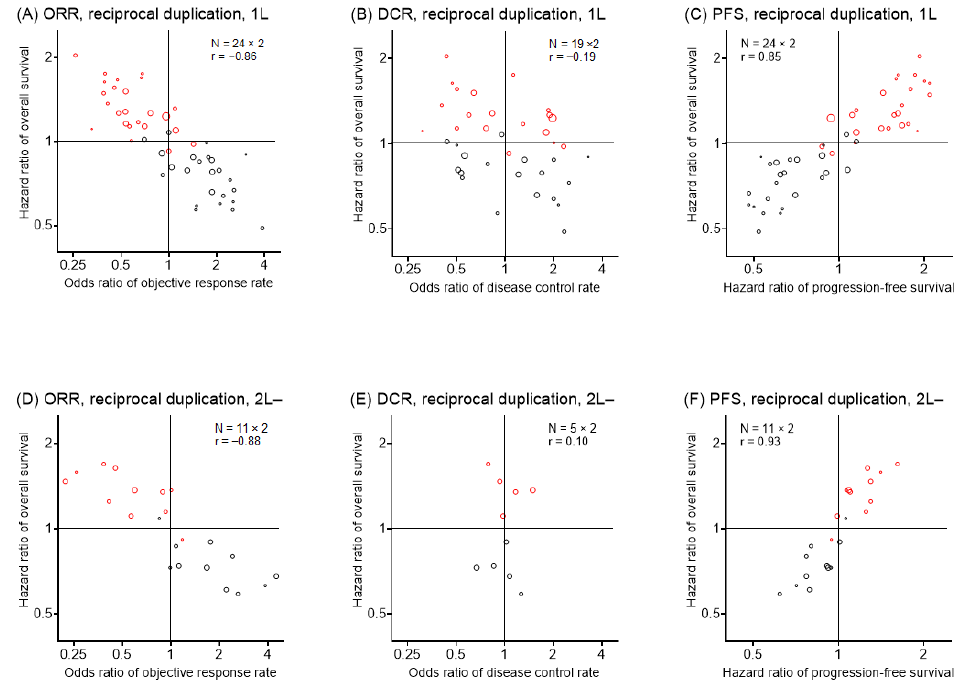
Figure 3. Study level-surrogacy following reciprocal duplication, subgroup analysis. Each circle represents one trial. Circle size represents study weight. Red circles indicate the point-symmetry of the original samples (black circles) for reciprocal duplication. N , number of trials; r, weighted rank correlation coefficient. ORR, odds ratio; DCR, disease control rate; PFS, progression-free survival. 1L, first-line subgroup; 2L-, second- or later-line